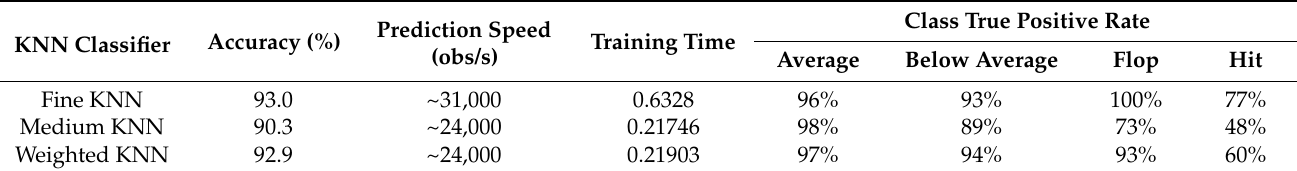
Table 7. Summary of the results for different KNN